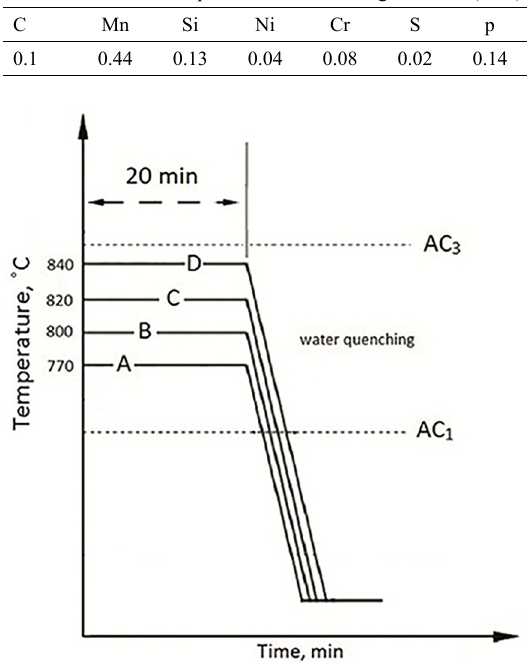
Figure 1. Schematic illustration of heat treatment cycle used in this